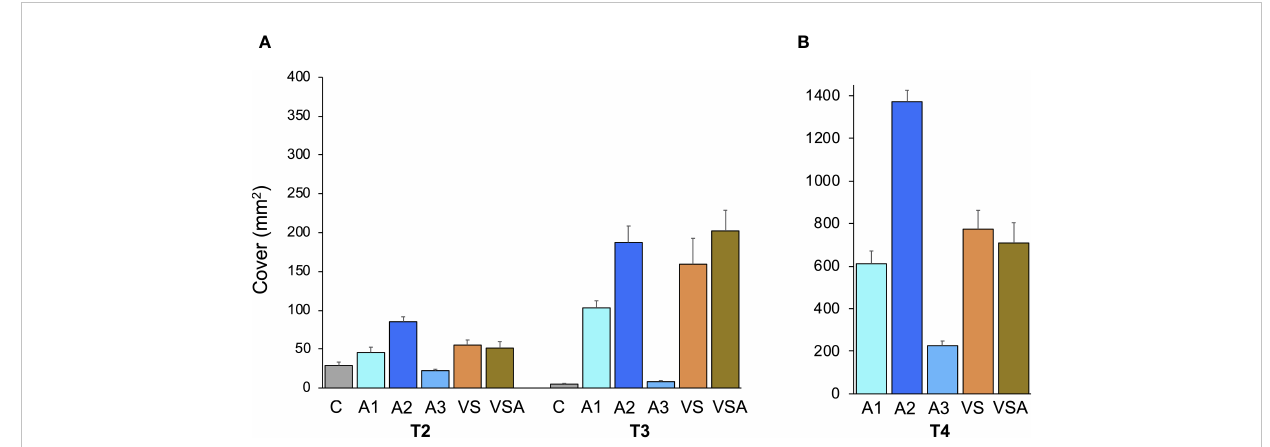
FIGURE 2 Mean values (± SE) of tile area covered by Ericaria amentacea seedlings: (A) in mesocosm at T2 (10 days post fertilization) and T3 (21 days post fertilization); (B) after 3 weeks in fi eld culture (T4). C (seawater, SW); A1 (SW with Algatron 2 mL L -1 ); A2 (SW with Algatron 4.5 mL L -1 ); A3 (SW with Algatron 9 mL L -1 ); VS (SW with addition of von Stoch); VSA (SW with addition of von Stoch and Algatron 4.5 mL L -1 ). At T4, no seedlings could be measured for C, as the tiles were free of